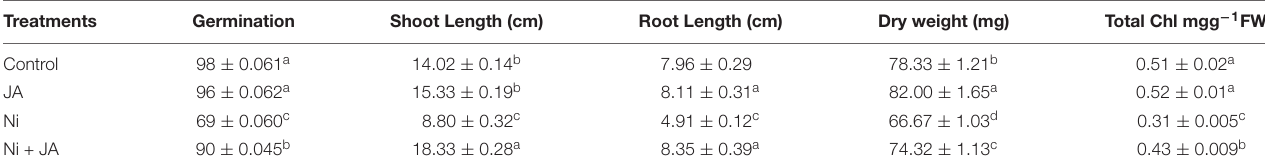
Data presented are the means ± SE (n = 5). Different letters next to the number indicate significant difference (P < 0.05).